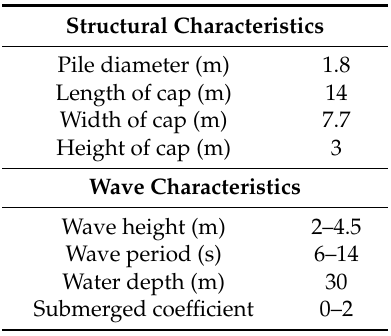
Figure 6. Variations of the flow velocity around the pile without cap.